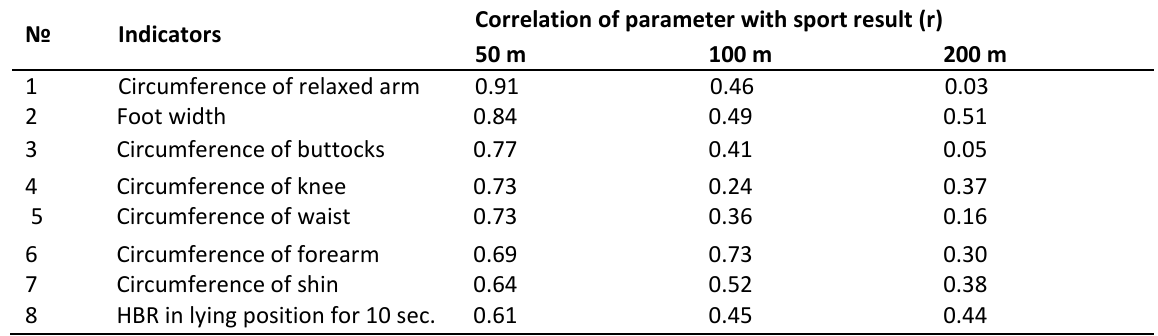
Table 1. Significance of breaststrokers’ morphological functional indicators, depending on competition distance